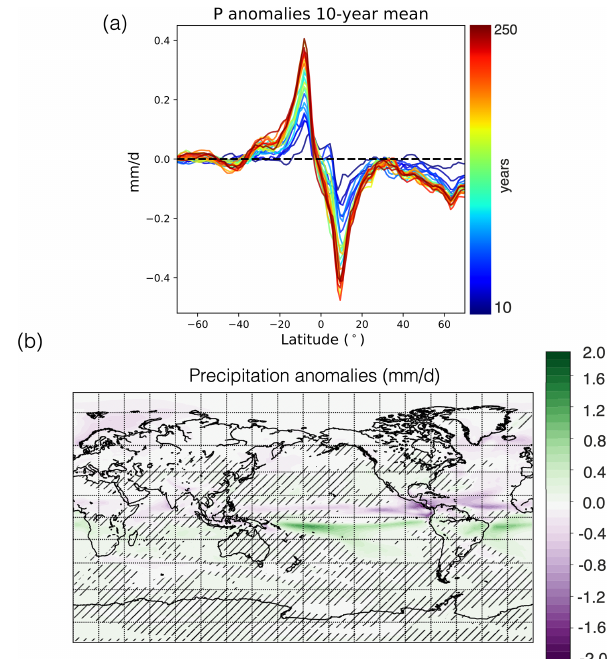
Figure 8. Each line in panel (a) corresponds to a 10-year mean of LIG_hosing–LIG precipitation ( P ) anomalies. In panel (b) , the long-term mean of P anomalies is shown. Non-hatched areas cor- respond to statistically significant differences (at 95%